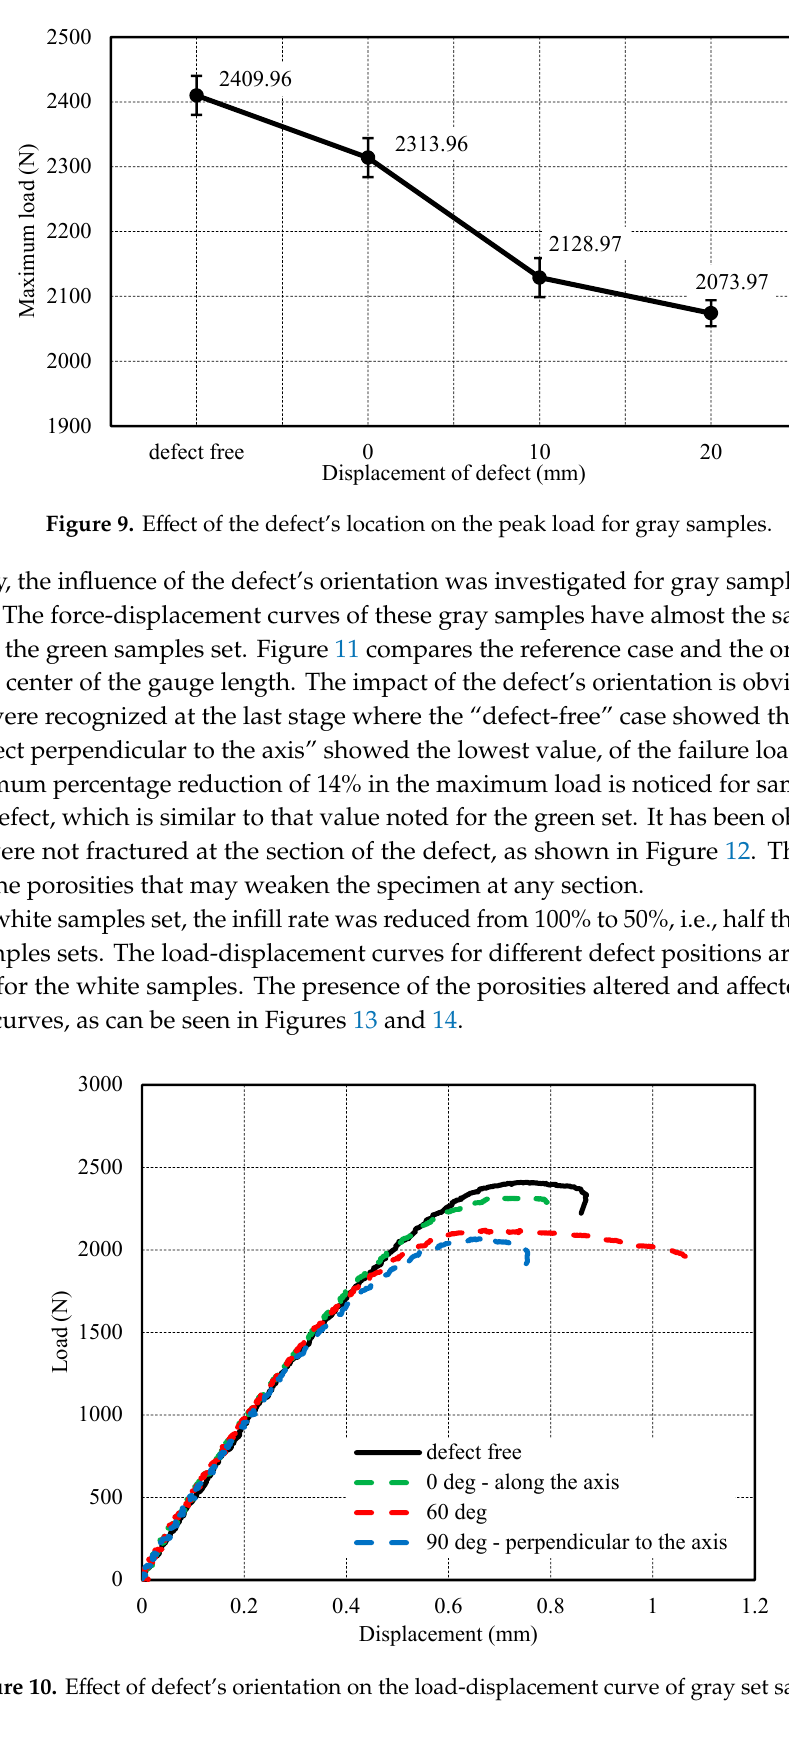
Figure 8. Load-displacement curves for the gray set specimens with different defect locations from the sample center.